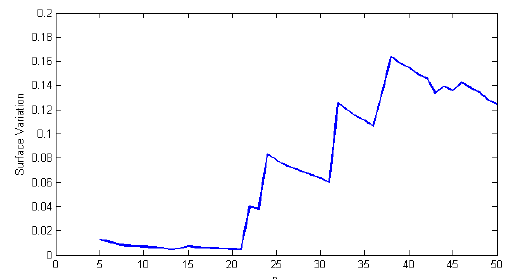
Figure 1. Change of surface variation with neighborhood size